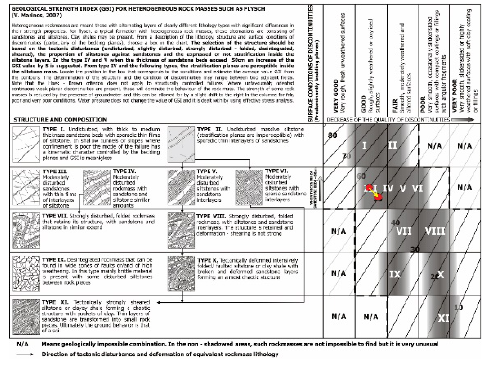
Marinos, 2007) Figure 2: GSI chart ( and value for rock mass (red dot). Table 1: Tunnel geometry and discontinuity orientation.